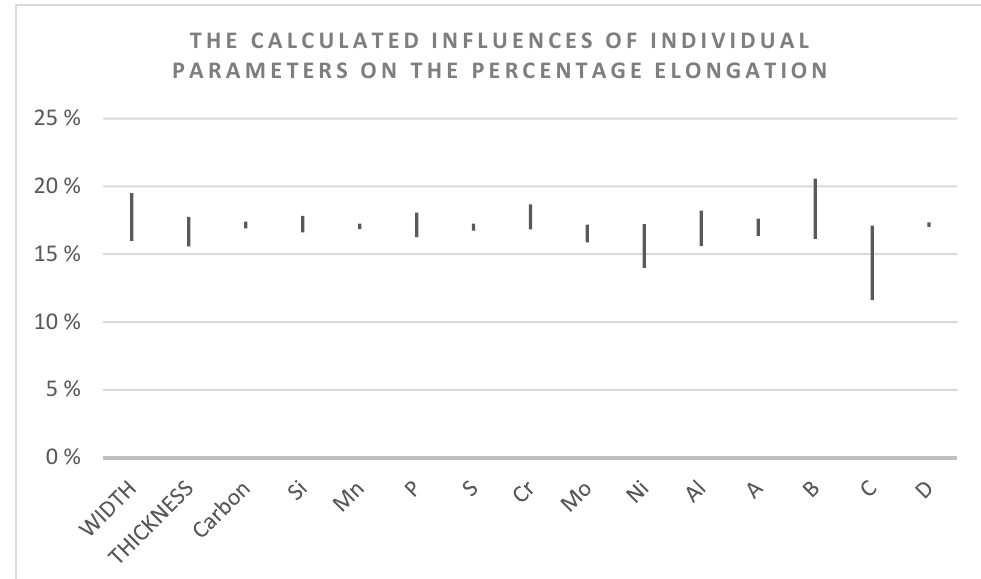
Figure 4. The calculated influences of individual parameters on the percentage elongation while separately changing individual parameter within the individual parameter range.